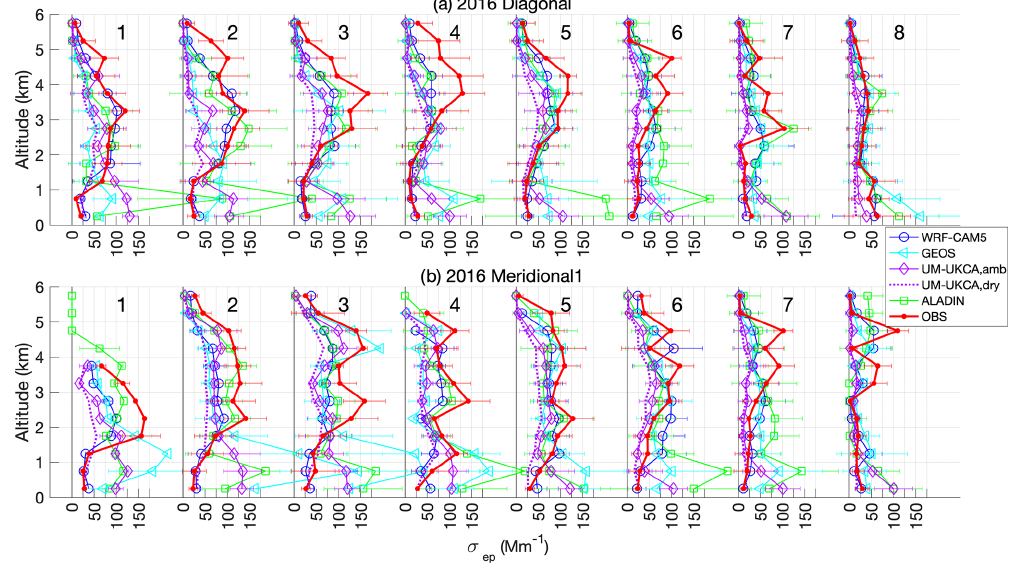
Figure 6. Profiles of σ ep , as observed in situ from the P-3 aircraft (low RH; 530nm), and modeled (ambient RH and, for UM-UKCA only, dry; 550nm) for (a) the 2016 diagonal transect and (b) 2016 meridional 1 transect. All values are means and standard deviations calculated across only those times and locations when in situ measurements were made. Grid boxes are numbered as in Fig. 1.